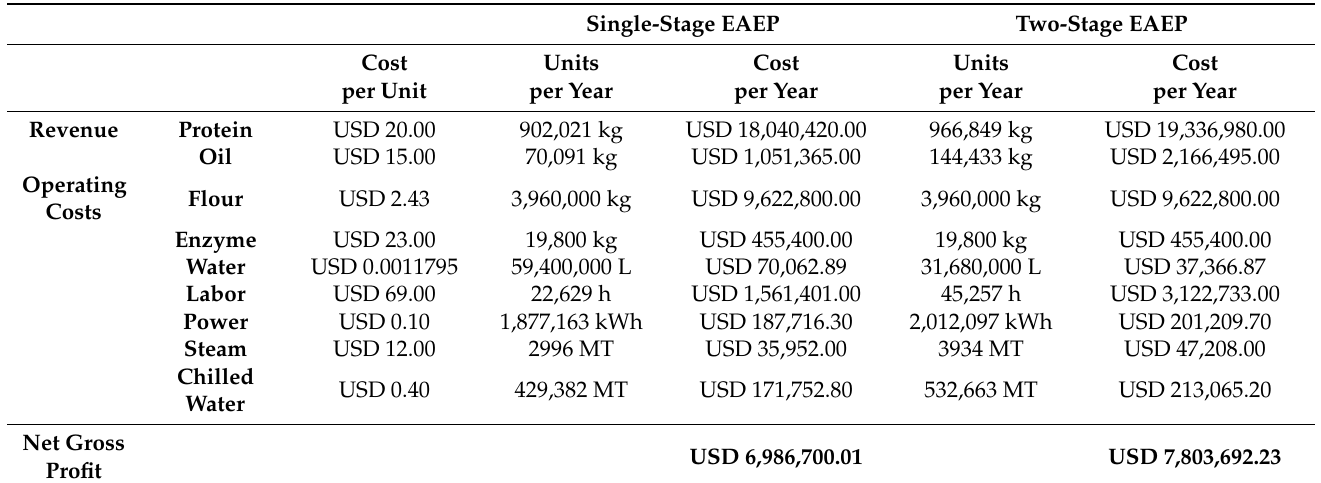
Table 2. Price points, early production and consumption, yearly revenue and operating costs, and total net gross profit of single-stage EAEP and two-stage countercurrent EAEP of chickpea full-fat